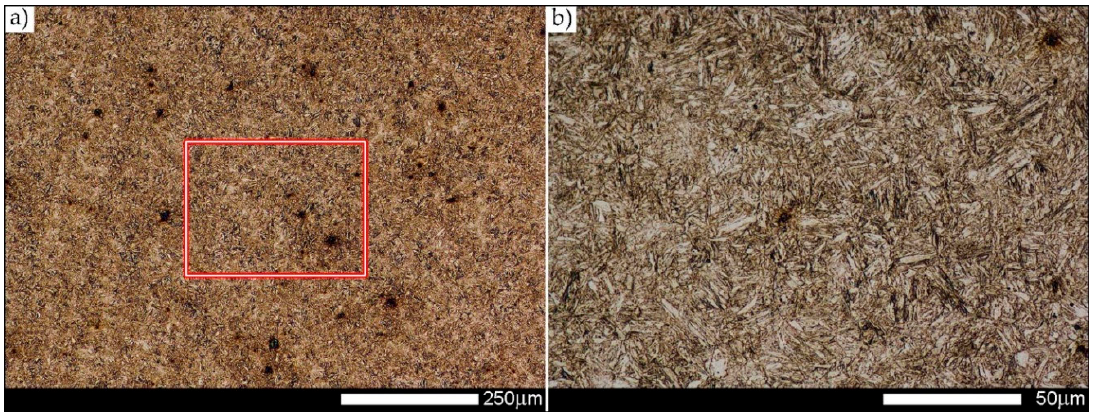
Figure 13. Microstructure of Hardox Extreme welded joint after heat treatment: ( a ) in the area marked WM1 in Figure 6; ( b ) an enlarged image marked with frame in Figure 13a. Structure of fine-lath hardening martensite with clear banding features resulting from former dendritic structure. Light microscopy, etched with 2% HNO 3 .